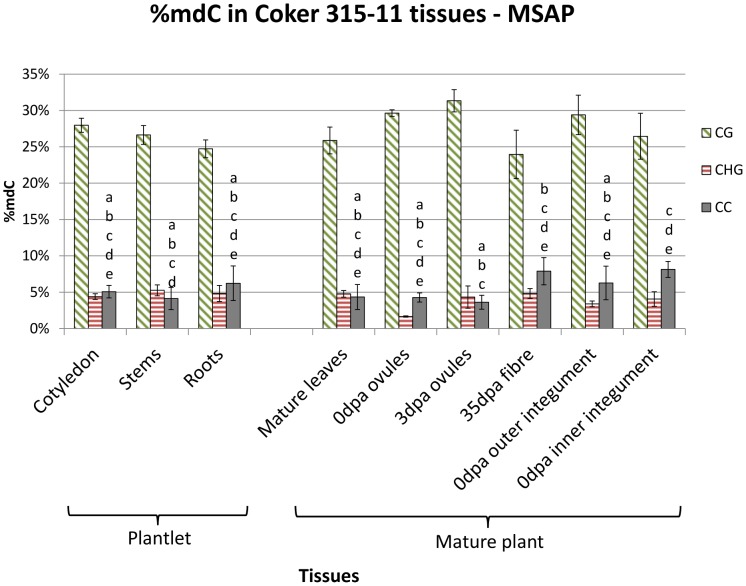
Methylation level of Coker 315-11 tissues determined by MSAP.Methylation was categorized into CG, CHG and CC methylation and represented as a bar graph. Significant differences are denoted by different letters for CC methylation. The error bars represent the standard error of mean from at least three biological replicates. No significant differences for CG and CHG methylation were found.